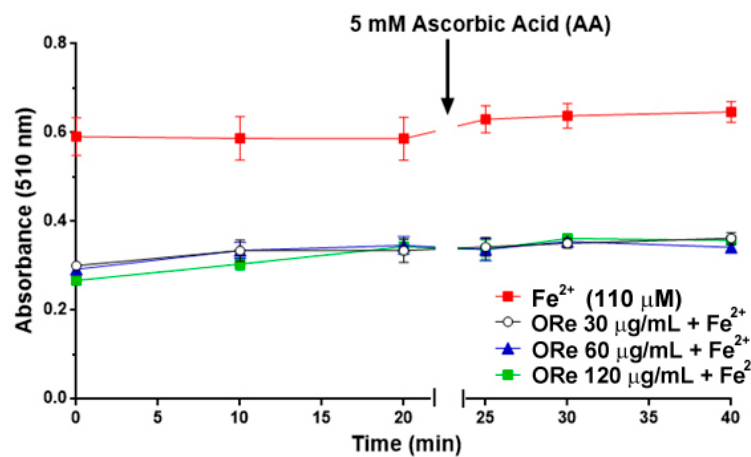
Figure 7. Oxidation of Fe 2+ by R. echinus leaf essential oil (30–120 μ g/mL). The essential oil was incubated with FeSO 4 (110 μ M) for 10 min. Then, ortho-phenanthroline was added and the absorbance of the reaction was measured at 0, 10 and 20 min following its addition of ortho -phenanthroline. After the last reading (at 20 min), 5 mM of ascorbic acid (AA) was added and the absorbance was read again at 5 min, 10 min and 20 min. Values represent the mean ± SEM of 3 independent experiments performed in duplicate. ORe = R. echinus leaf essential oil.